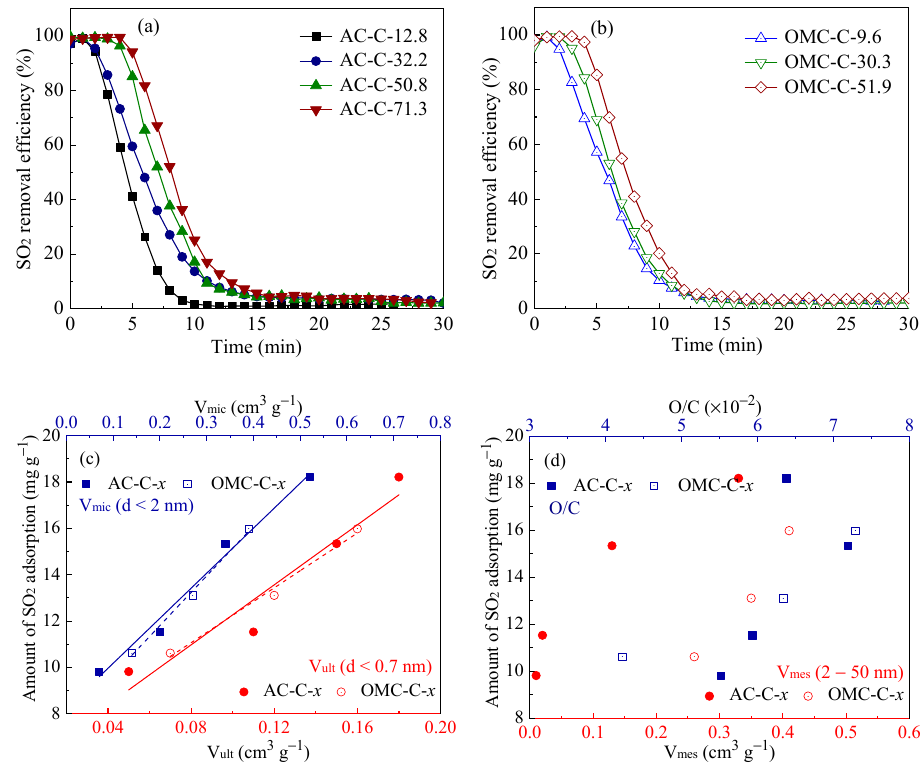
Figure 4. SO 2 -adsorption performance of the AC and OMC samples. SO 2 removal efficiency for ( a ) AC-C- x and ( b ) OMC-C- x . Adsorption conditions: 2.5 g of adsorbents, 1500 ppm SO 2 , N 2 balance, flow rate 1.2 L · min − 1 , at 313 K. The correlations of calculated SO 2 adsorption amount and the physico-chemical parameters: ( c ) Ultramicropore volume (V ult ) and micropore volume (V mic ); ( d ) mesopore volume (V mes ) and O/C.